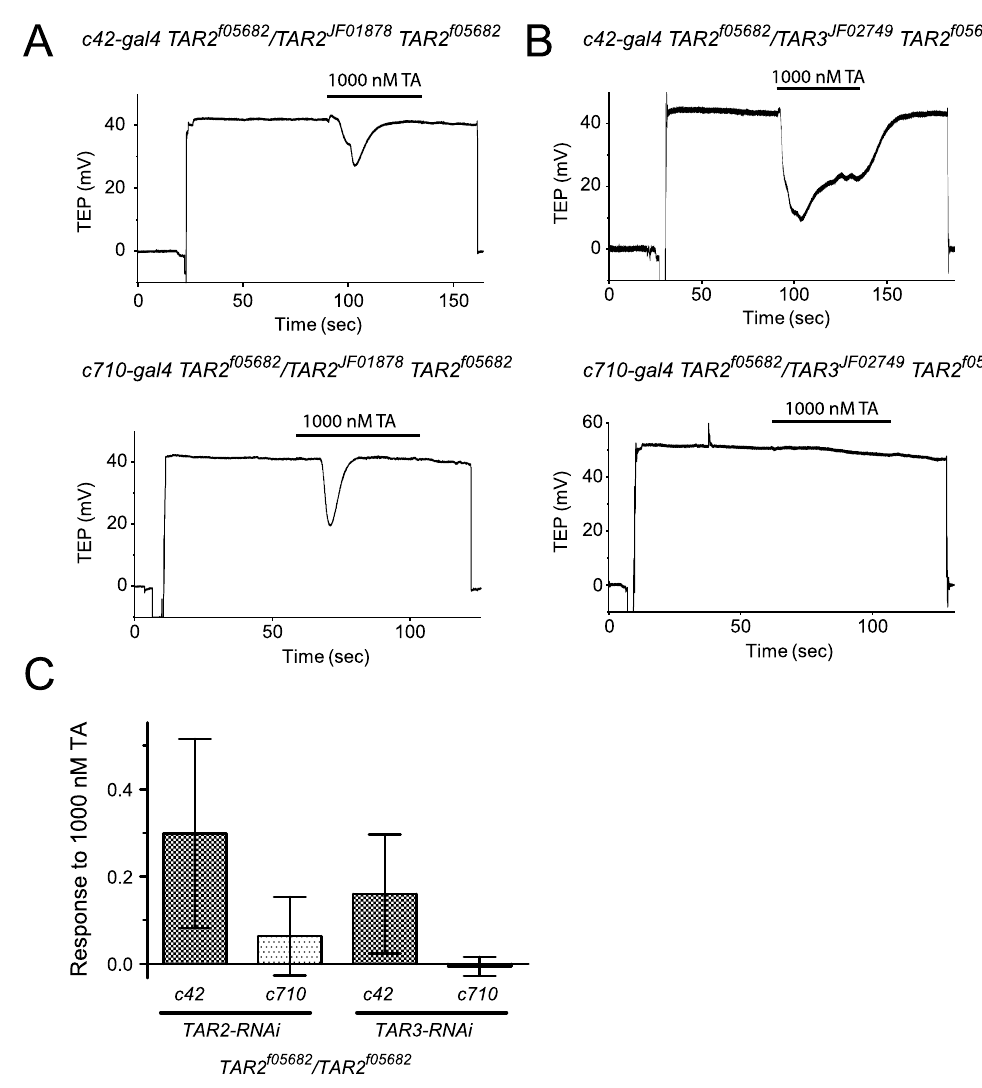
Figure 4. Effect of RNAi against TAR2 and TAR3 on a TAR2 mutant background. ( A ) Representative responses to 1000 nM TA from c42-gal4 TAR2 f05682 /TAR2 JF01878 TAR2 f05682 (upper trace) and c710-gal4 TAR2 f05682 / TAR2 JF01878 TAR2 f05682 (lower trace) tubules. ( B ) Representative responses to 1000 nM TA from c42-gal4 TAR2 f05682 /TAR3 JF02749 TAR2 f05682 (upper trace) and c710-gal4 TAR2 f05682 /TAR3 JF02749 TAR2 f05682 (lower trace) tubules. ( C ) Mean responses to 1000 nM of the four genotypes shown in ( A and B ). Knockdown of both TAR2 and TAR3 in the stellate cells caused a significant reduction in the response compared to knockdown in principal cells, p < 0.05, 1-way ANOVA and Sidak’s multiple comparisons test, but only knockdown of TAR3 in the stellate cells resulted in a mean response that was equal to zero, p = 0.45, 1-sample t-test. n = 8–9 tubules per